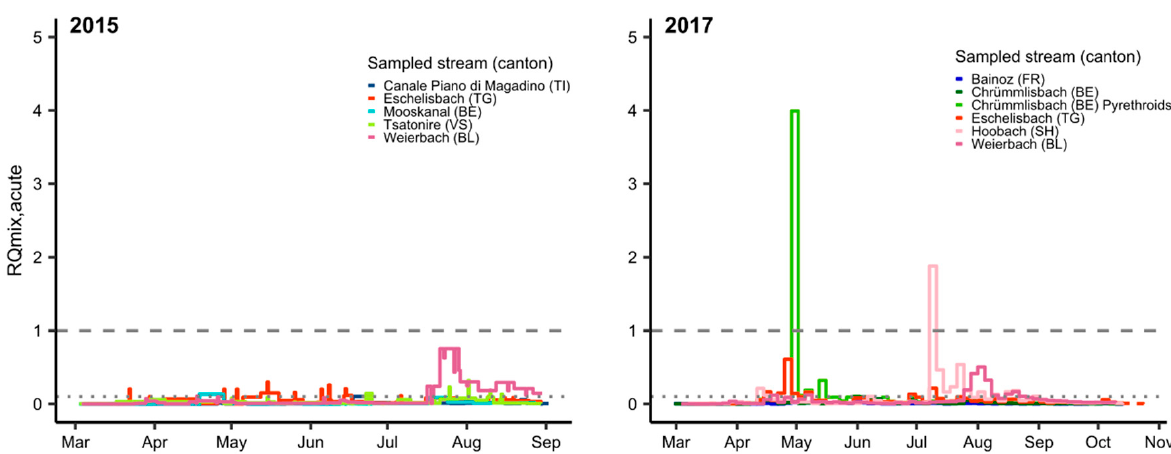
Figure 1. Acute mixture risk quotients (RQ mix, acute ) for fish in composite water samples from small streams in Switzerland in 2015 and 2017. Two thousand and fifteen: acute exposure scenario (ExpSc) based on 0.5–24 day time-proportional (TP) composite samples; 2017: acute ExpSc based on 3.5 day TP composite samples; pyrethroids were analyzed at only 1 of 5 sites (Chrümlisbach, BE). RQ mix (Chrümlisbach, BE, pyrethroids) is based solely on data for pyrethroids. Gaps indicate periods when no samples were collected; the dashed line indicates RQ = 1, and the dotted line indicates RQ = 0.1.